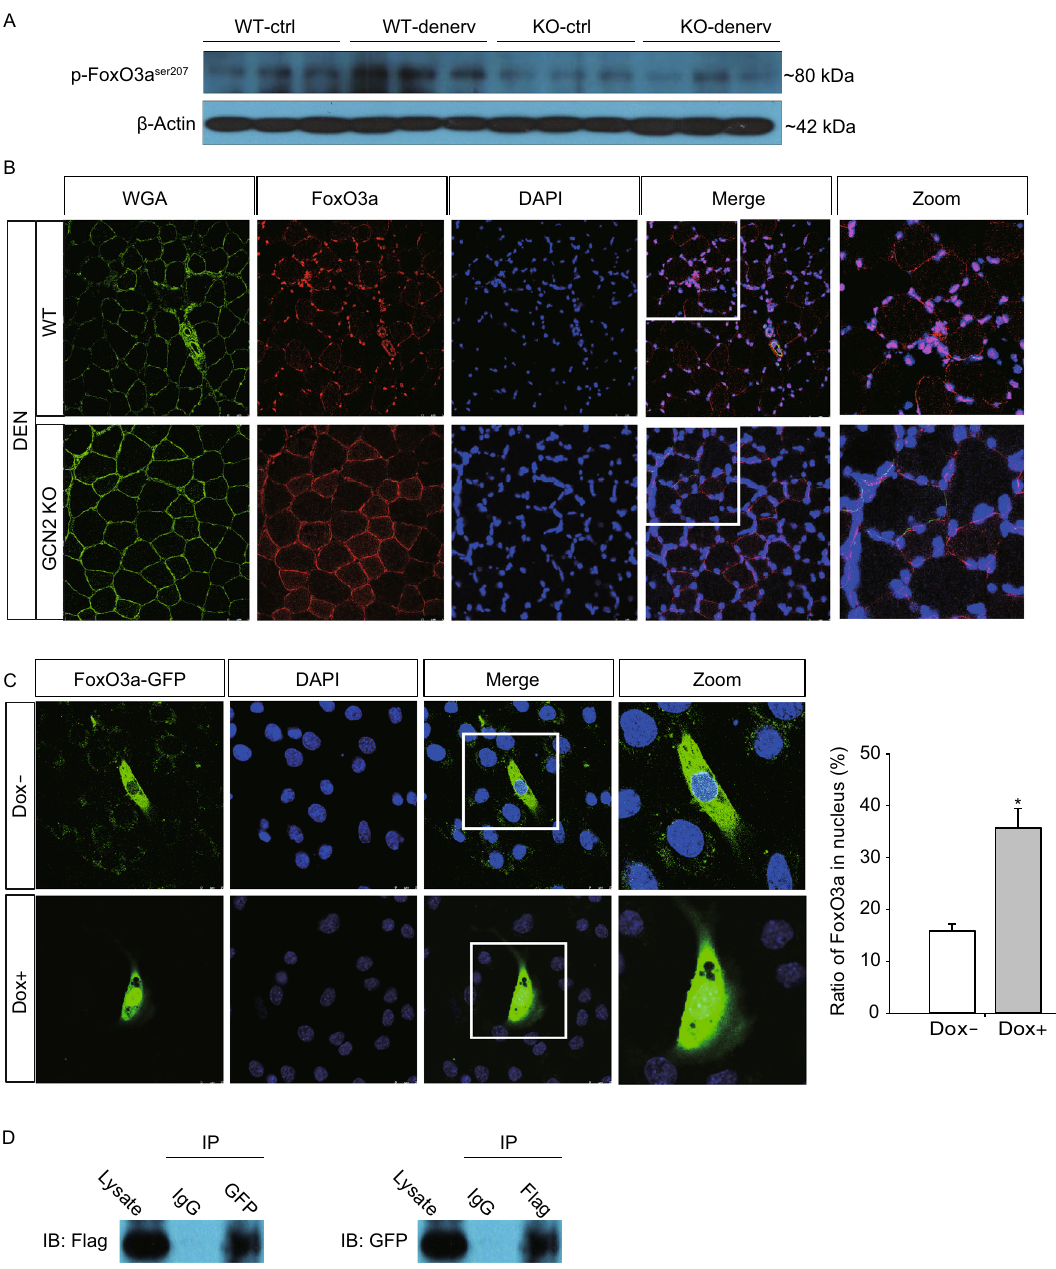
Figure 2. Effect of GCN2 on FoxO3a activation and nuclear translocation . (A) TA muscles were collected from WTand GCN2 − / −